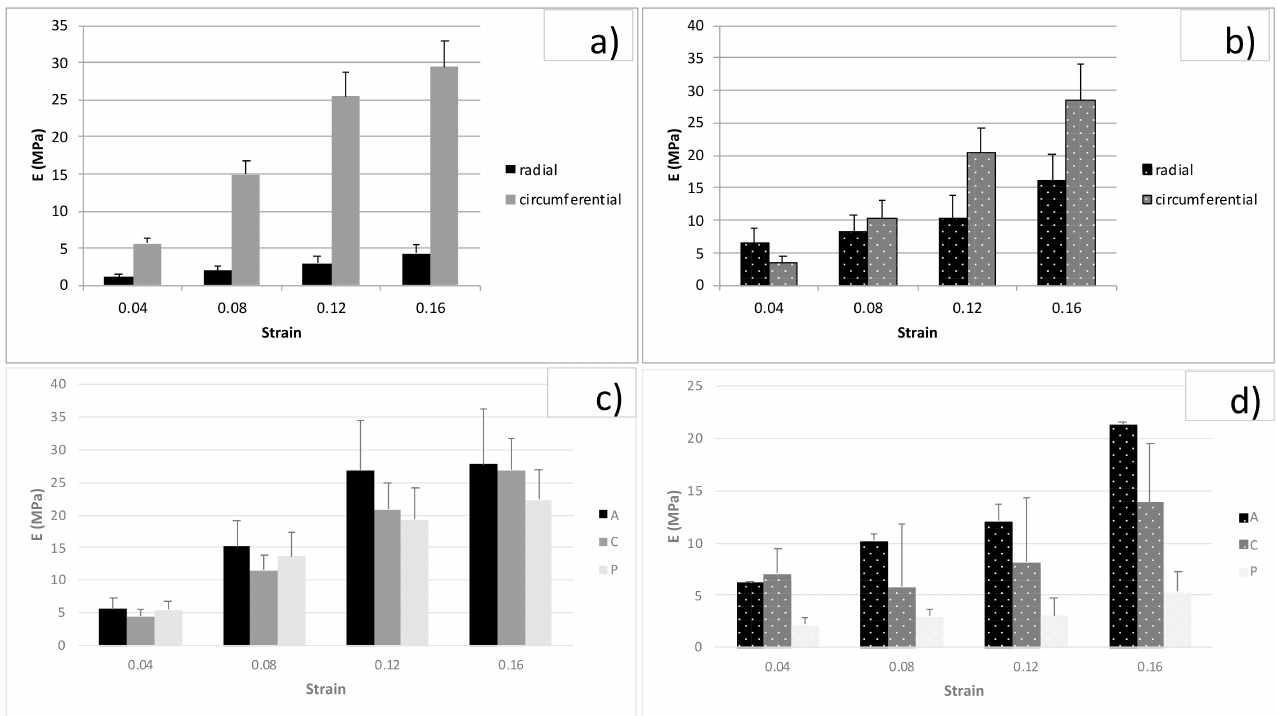
Figure 5. Tension tests: relaxation moduli for different strain levels, from 0.04 to 0.16, for different directions—radial and circumferential—and different zones—anterior (A), central (C), and posterior (P). ( a ) Radial and circumferential values for FD menisci; ( b ) radial and circumferential values for PD menisci; ( c ) anterior (A), central (C), and posterior (P) values for circumferential FD menisci; and ( d ) anterior (A), central (C), and posterior (P) values for circumferential PD menisci. Bars are standard errors.